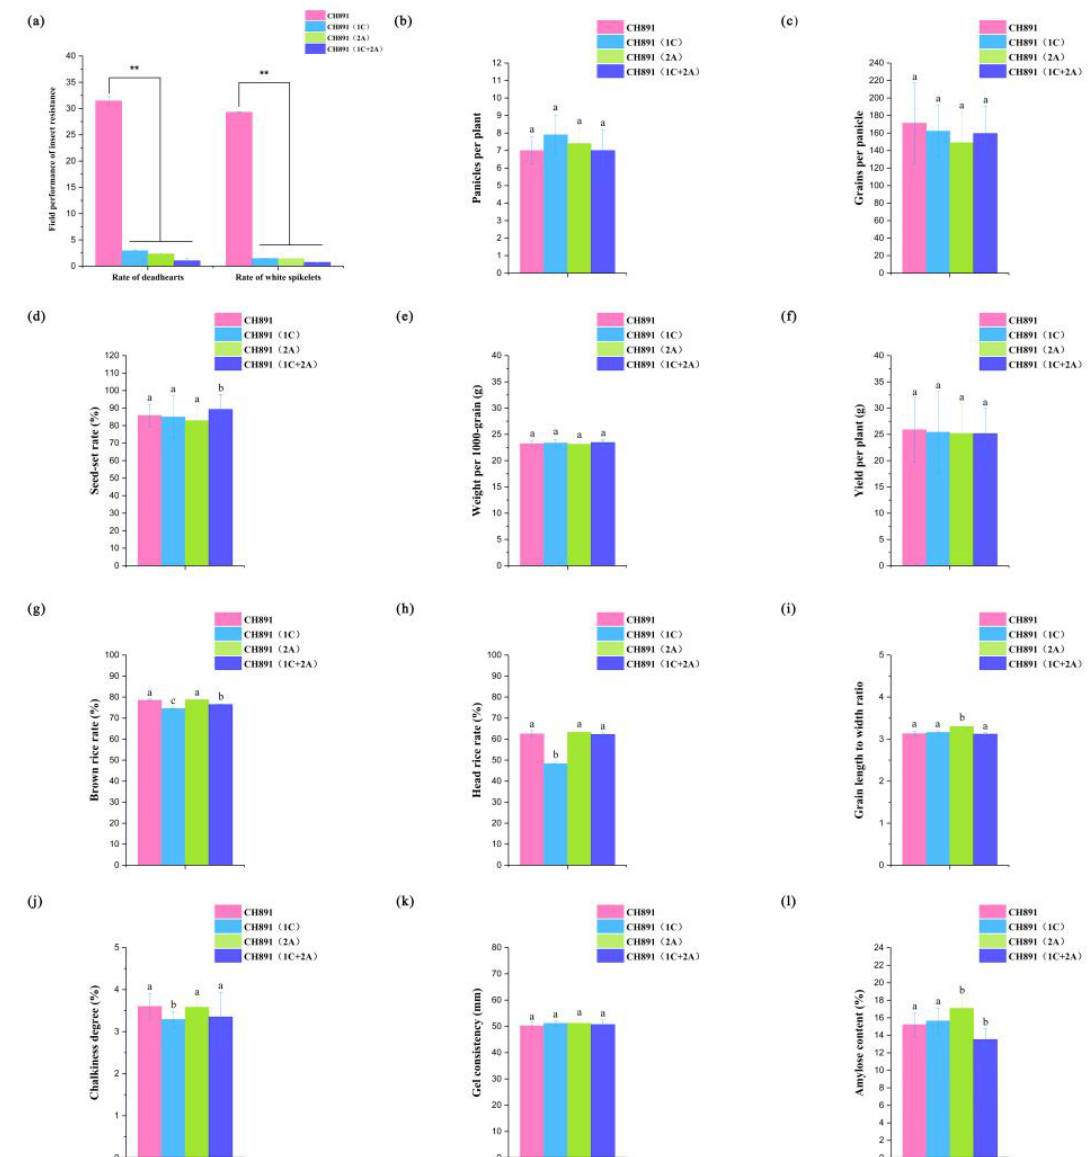
Figure 3. Comparison of a recurrent parent (CH891) with CH891(1C), CH891(2A), and CH891(1C+2A) transgenic restorer lines that resistance to C. suppressalis , and agronomic traits, respectively. ( a ). The reaction of the three transgenic restorer lines and their parent on insect larvae damage under natural infestation at the tillering and heading stage in Nanchang field (E115.5 ◦ , N28.5 ◦ ), China. ( b – l ). Bar charts of the 12 agronomic and end-use quality traits recorded in three transgenic lines and their recurrent parent. The phenotype data were based on one environment. The bars indicate the standard deviations, and the median horizontal line indicates the mean. See Table S9 for Pairwise comparisons. Data of each test were analyzed by one-way ANOVA (** p < 0.01). Data followed by different lower-case letters denote significant differences between agronomic traits at the 5% level according to LSD